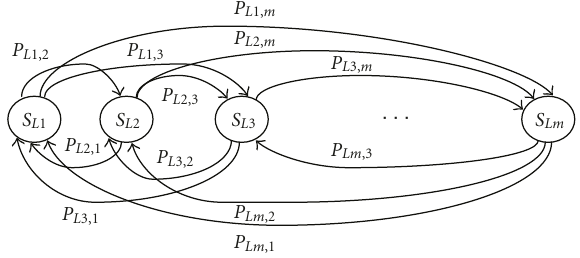
Figure 2: Modeling of user movement by a finite-state Markov